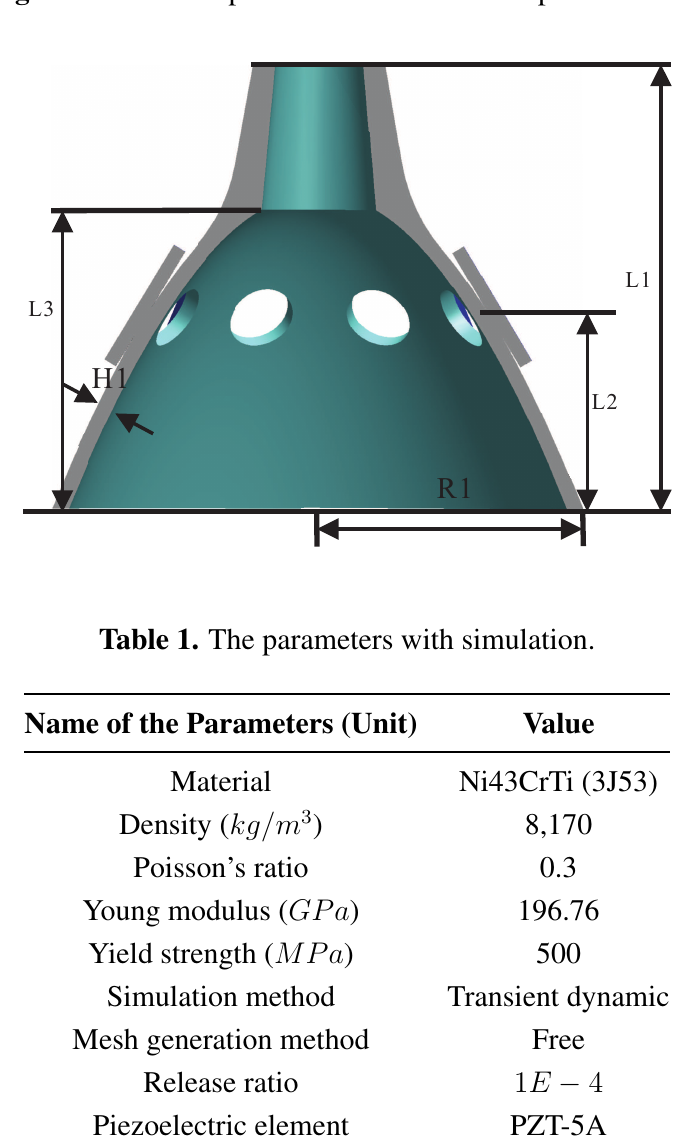
Figure 9. Structure parameters of the bell-shaped resonator.